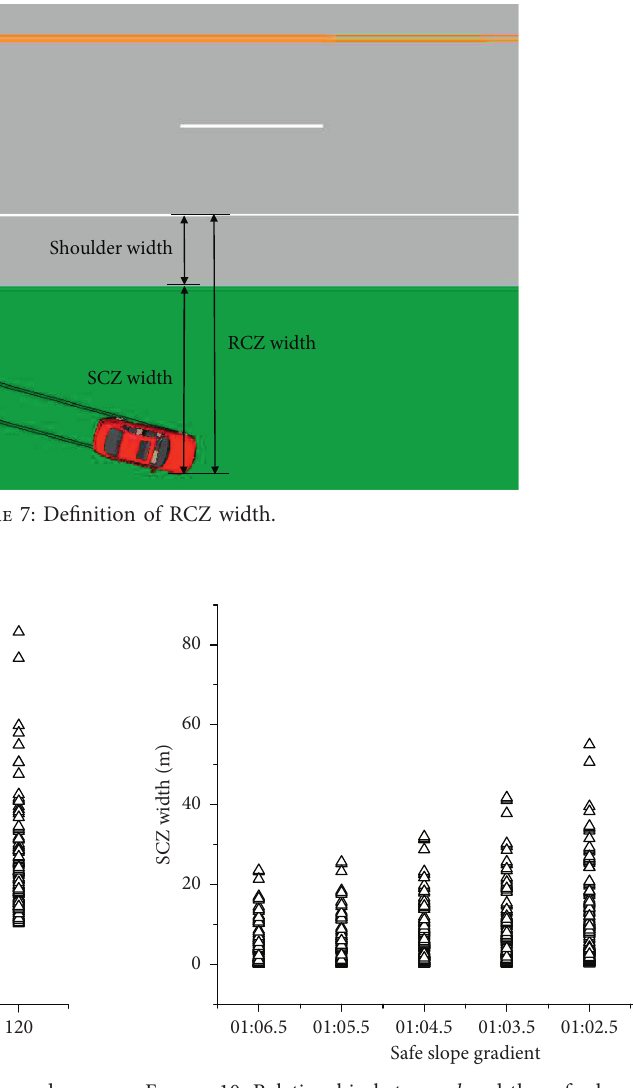
Figure 10: Relationship between l and the safe slope gradient.